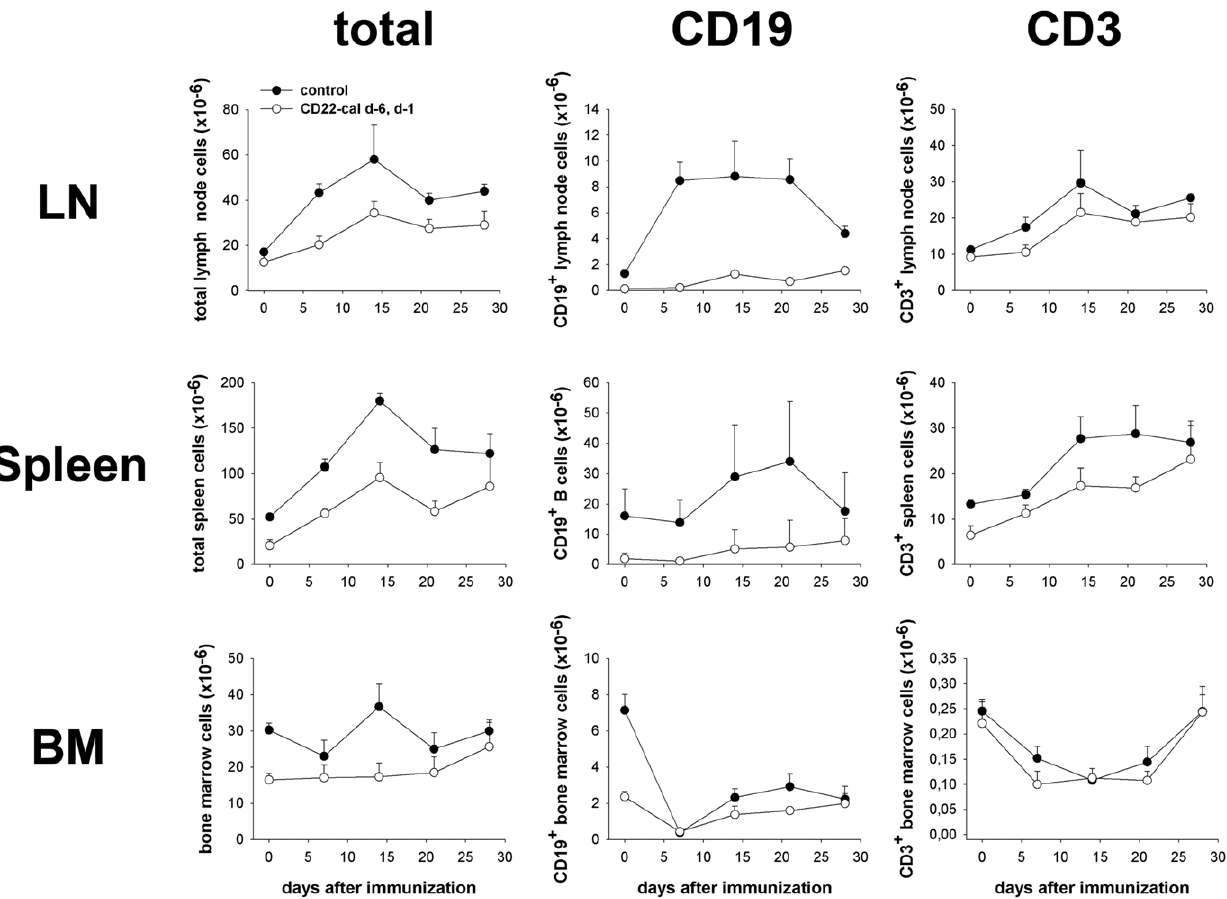
Figure 2. B cell depletion in CD22-cal treated mice. Mice were treated with CD22-cal at days 2 6 and 2 1 and were immunized with 400 m g G6PI in complete Freund’s adjuvant. Control mice were immunized but otherwise left untreated. Lymph nodes (LN), spleens and bone marrow were isolated, counted and analyzed for the percentage of CD19 + B and CD3 + T lymphocytes. Shown are the total number cells harvested (left) or the total number of B- (middle) or T-lymphocytes (right) in the various organs. Data are representative for at least three mice per time point.